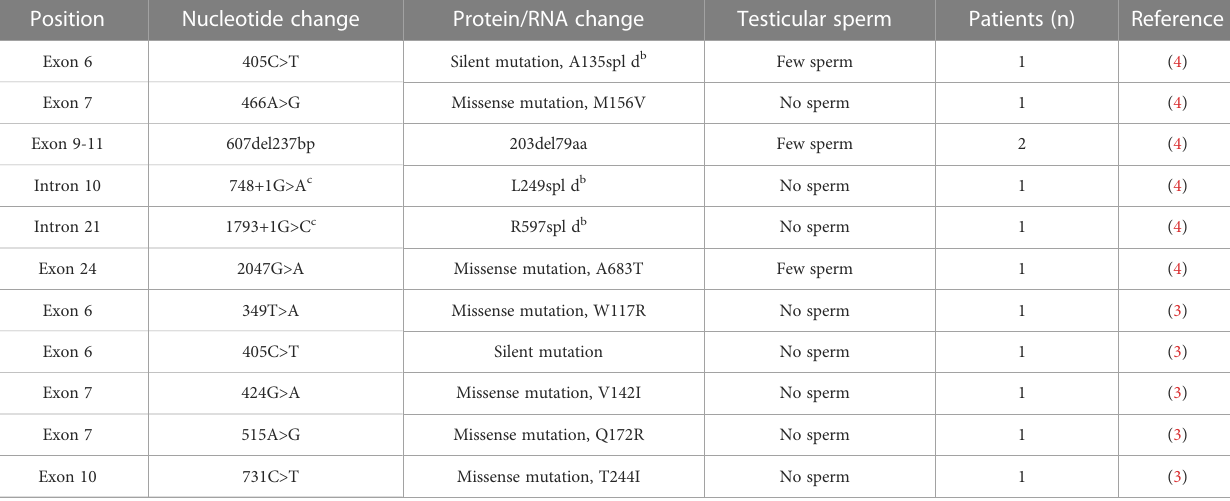
TABLE 2 Mutations of TEX11 reported for azoospermia patients in published literature and our